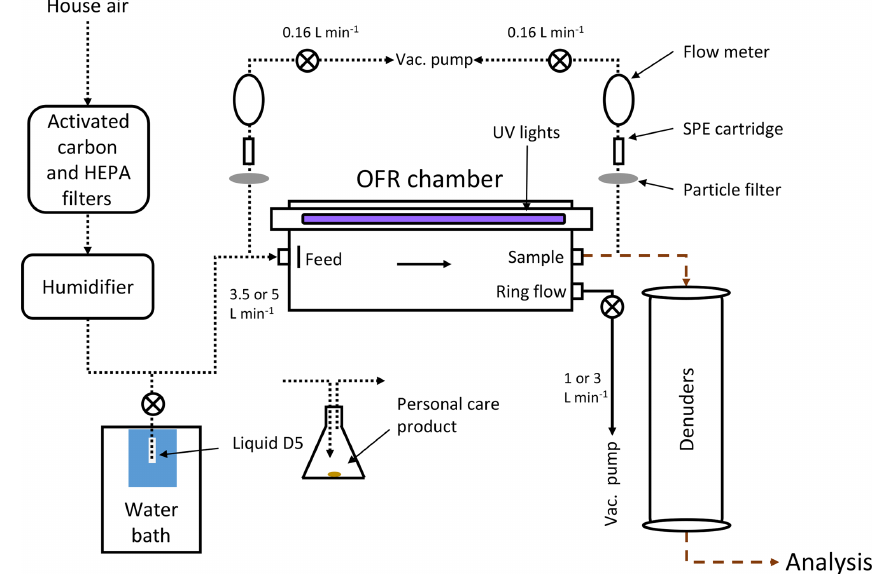
Figure 1. Flow diagram for generation of aerosols in the OFR. Aerosols were analyzed by SMPS, TPS100, V-TDMA, and DMT-CCN instruments. Delivery of the precursor gas was either by diffusion of liquid D 5 controlled by a water bath or flowing air past a personal care product placed in an Erlenmeyer flask. Short dashed lines in the diagram indicate Teflon tubing, long dashed lines represent copper tubing, and solid lines represent conductive silicon